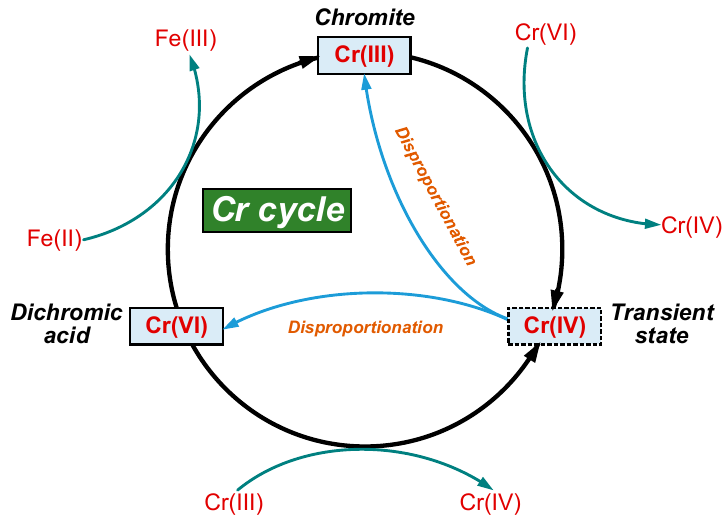
Figure 7. Cr cycle during the leaching process of chromite.